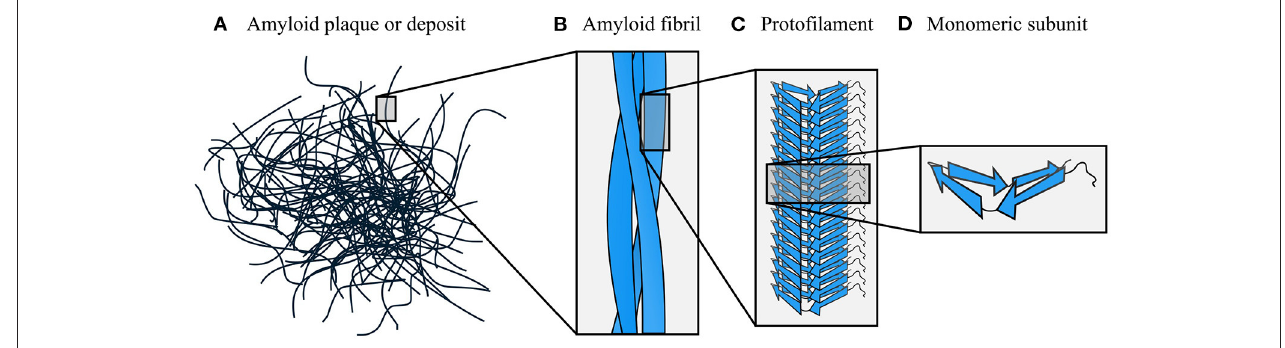
FIGURE 2 | Hierarchical organization of amyloid fibrils. The dominant components of amyloid plaques or deposits are amyloid fibrils (A,B) , which are formed by close lateral association of protofilaments (C) . In turn, protofilaments are formed by stacking of monomeric subunits, and usually consist of a single stack (D) . The density map obtained by Mizuno et al. (2011) was used as a template for the fibril schematic in part (B) .